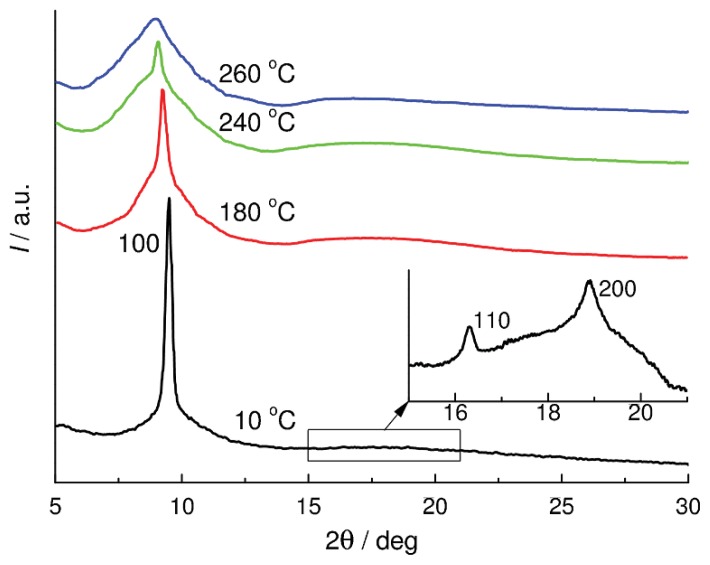
X-ray diffraction patterns of CL POCS IV-Et at different temperatures.